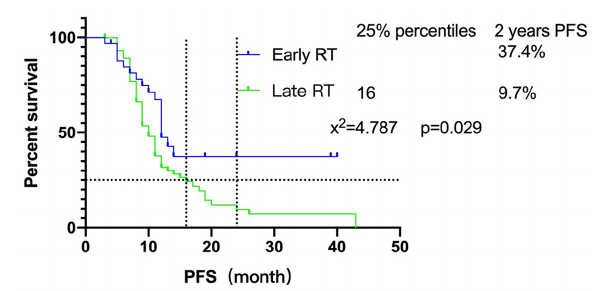
FIGURE 1 | The influence of radiotherapy intervening time on PFS between two groups.